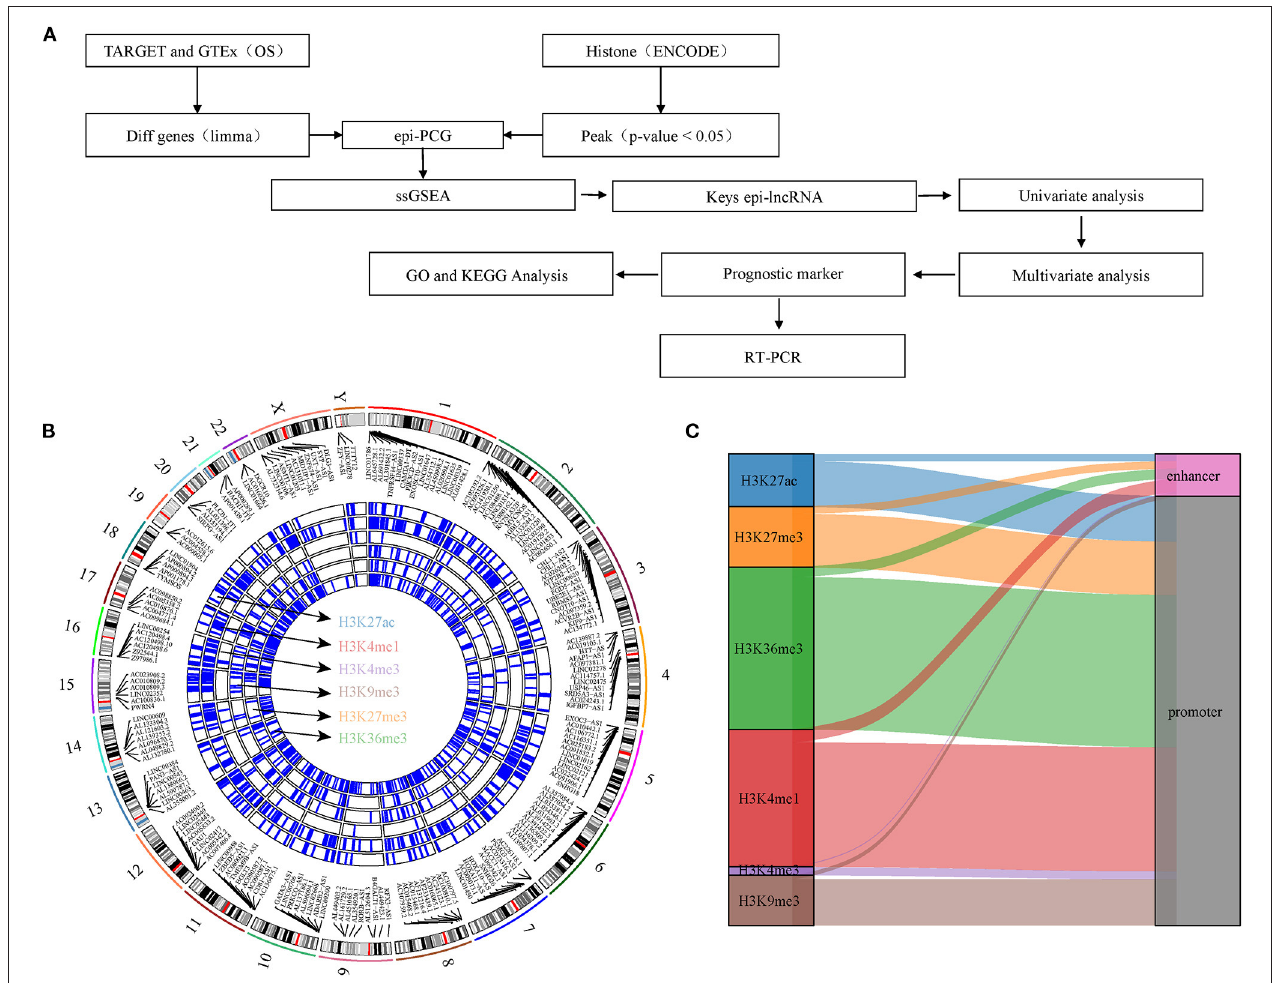
FIGURE 1 | Work flow chart and genomic landscape of epi-lncRNAs. (A) Workflow diagram of the study. (B) The locations on the chromosome of epi-lncRNAs shows the global apparent modification distribution. Epi-lncRNAs is marked in the appropriate location. (C) Alluvial diagram of six histone modification distributions of promoter and